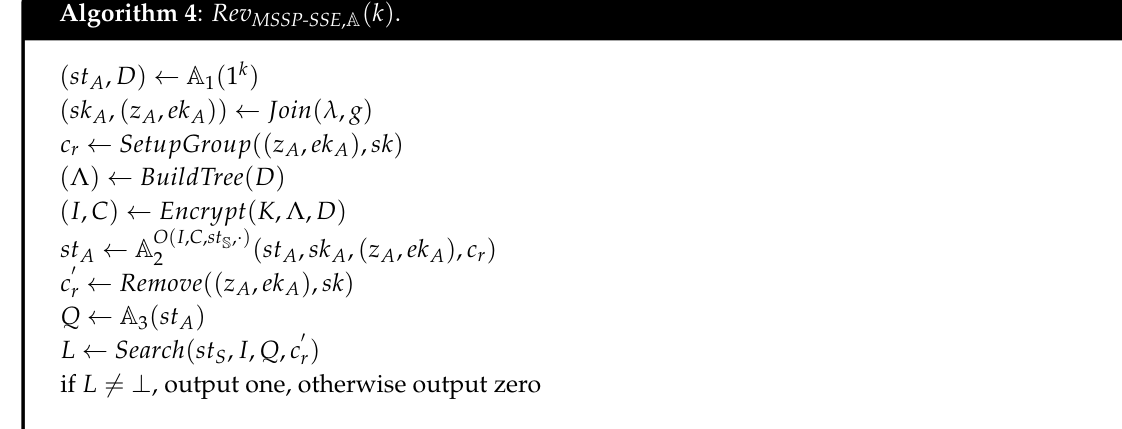
Algorithm 4 : Rev MSSP-SSE , A ( k )